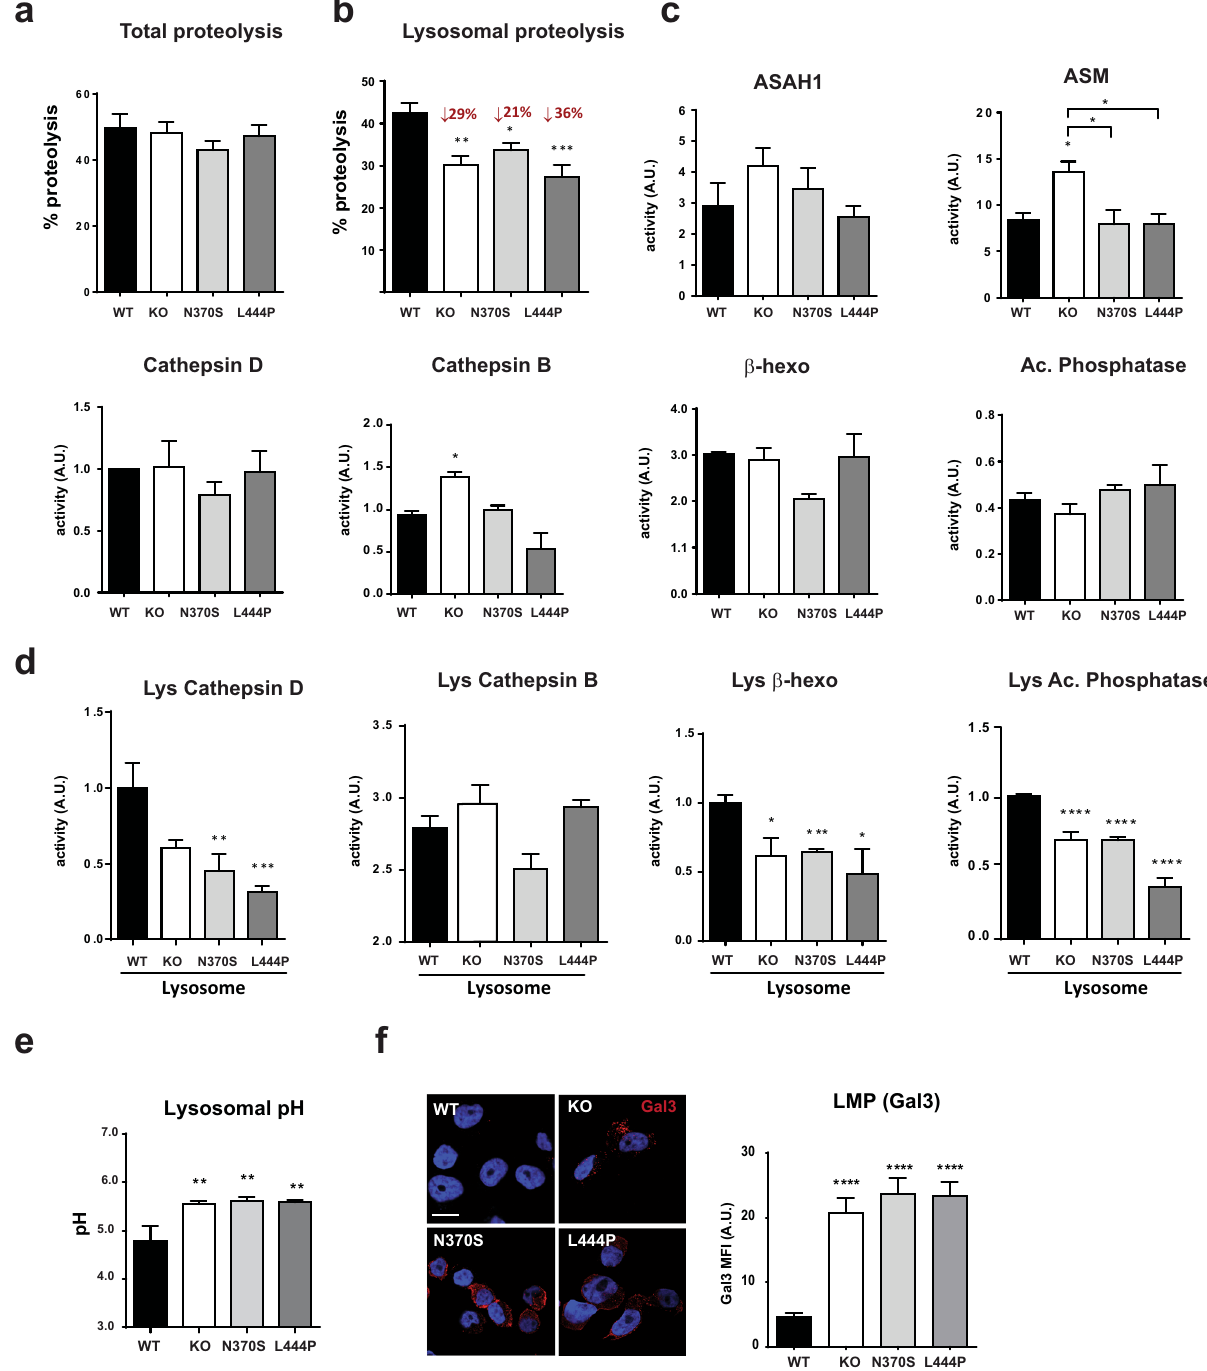
Fig. 4 Mutant GBA exhibit lysosomal dysfunction. a Total proteolysis measured by an intracellular protein assay, n = 12. b Lysosomal proteolysis measured by an intracellular protein assay, n = 12. c Enzymatic activity of lysosomal enzymes in total homogenates, n = 3 – 6 independent samples. d Enzymatic activity of lysosomal enzymes in lysosomal-enriched fractions, n > 3 independent isolations in each group. e Lysosomal pH quanti fi cation, n = 6 in each group. f Representative images and quanti fi cation of galectin-3 (red) determined by immuno fl uorescence. Nuclei are labeled with Hoechst 33342, scale bar = 10 µm, n = 30 cells/conditions. In all panels, data are presented as mean ± s.e.m. Statistical signi fi cance was established at * p < 0.05, ** p < 0.01, *** p < 0.001, **** p < 0.0001 compared to WT samples or between mutant lines when indicated after one-way ANOVA followed by Tukey ’ s multiple comparisons